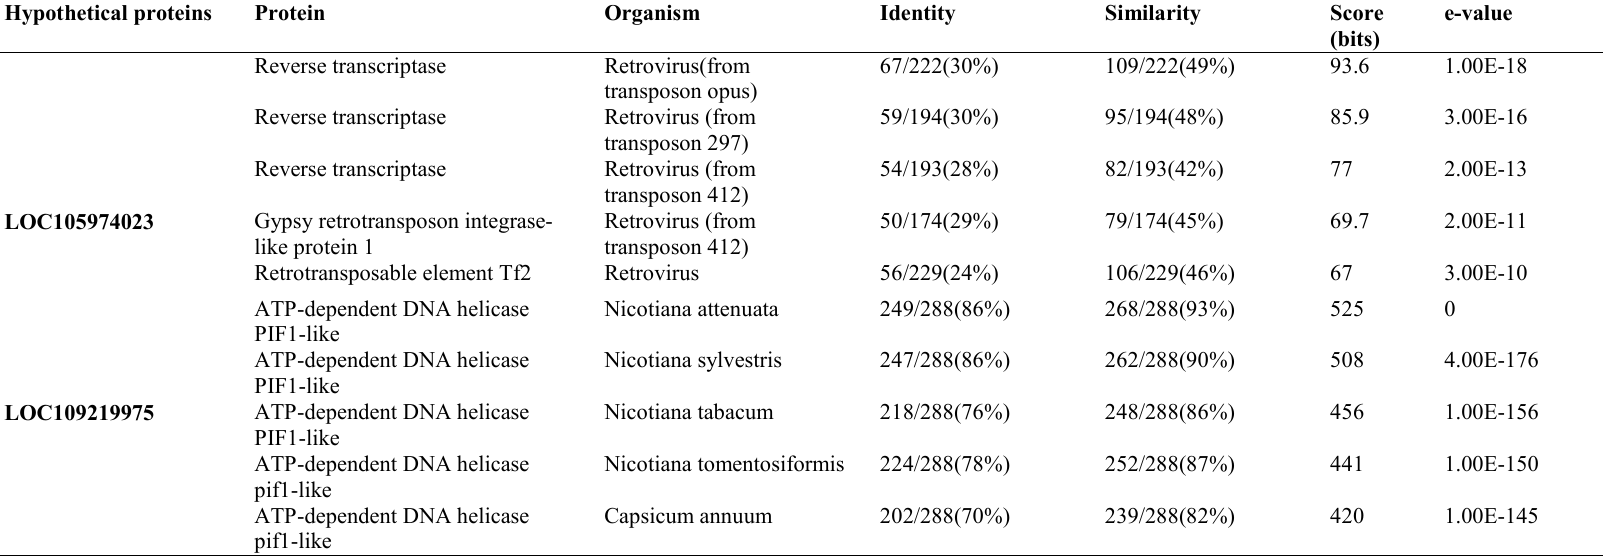
Table 2 . The output of the blastp searches for similar sequences against non-redundant UniProtKB/SwissProt sequences. Hypothetical proteins